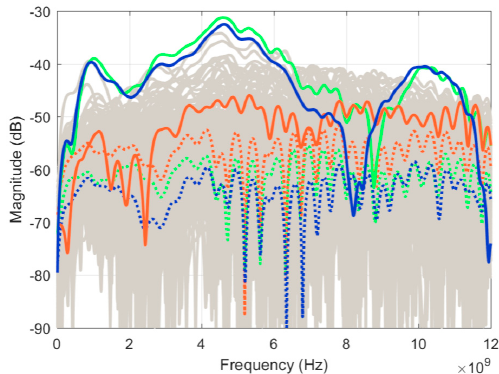
Figure 9. Differences between scans for each signal in the frequency domain. All signals are in grey with average values in dotted green, red, and blue for Scan2-Scan1, Scan 3-Scan1 and Scan3-Scan2 respectively. Residual response at position 127 in solid green, red, and blue for Scan2-Scan1, Scan 3-Scan1 and Scan3-Scan2, respectively.